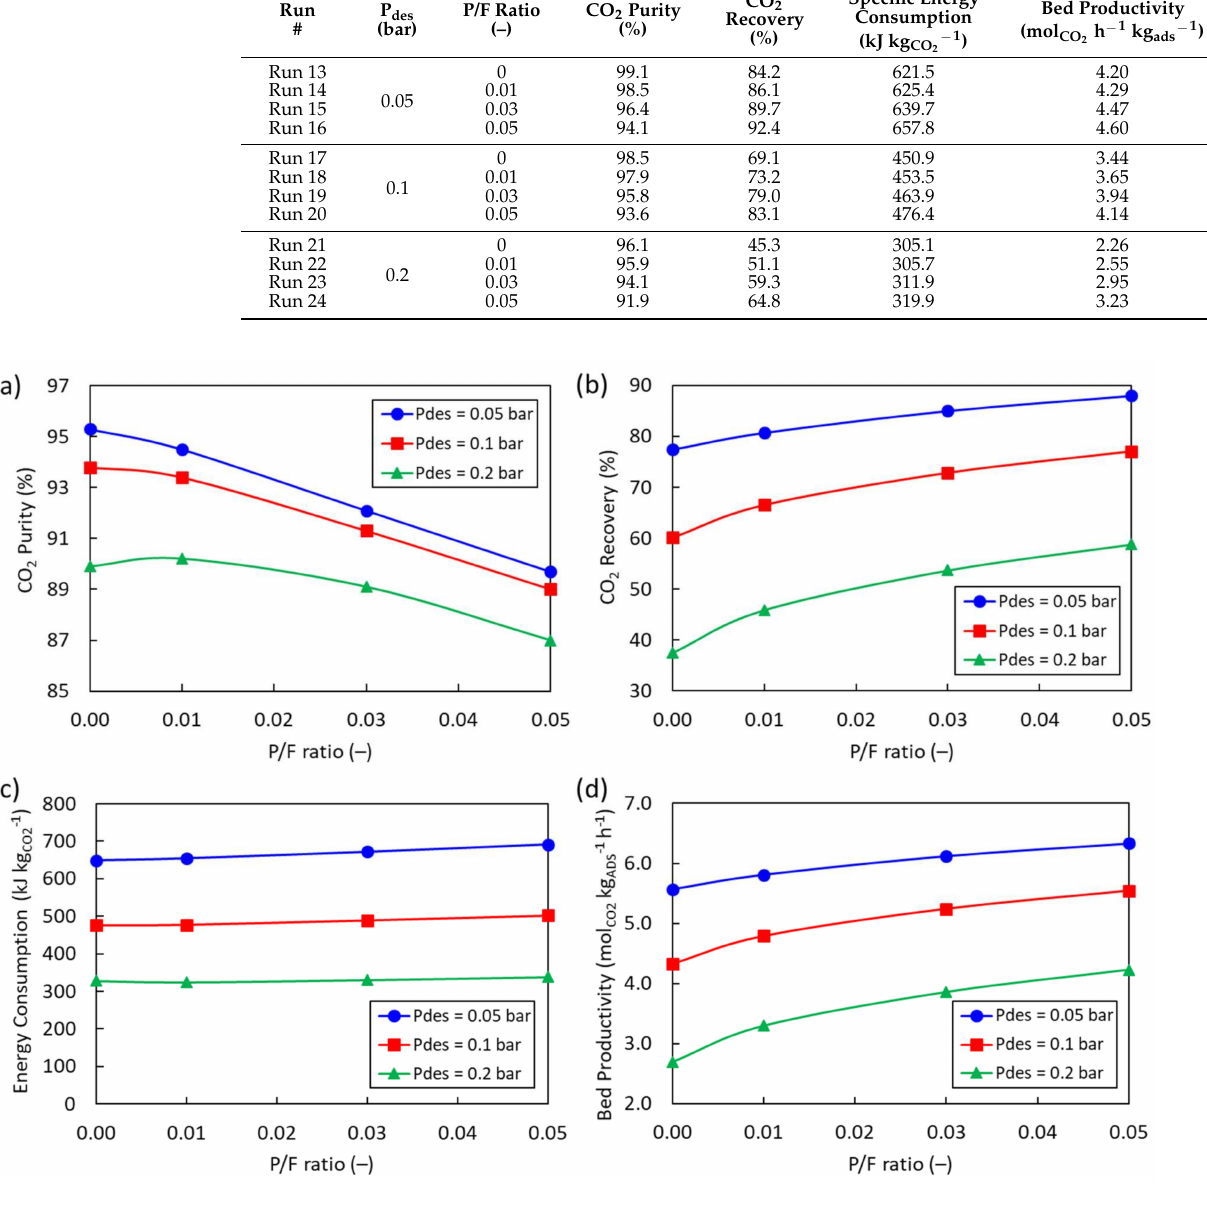
Figure 4. Evolution of the KPIs of the 2-bed, 4-step VPSA with the purge-to-feed ratio and desorption pressure: ( a ) CO 2 purity; ( b ) CO 2 recovery; ( c ) Specific energy consumption; ( d ) Bed